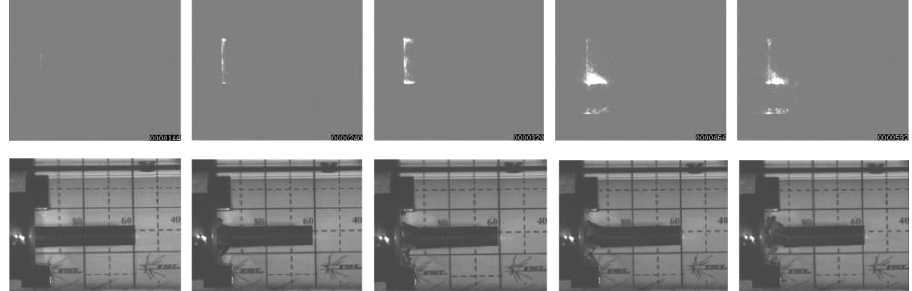
Fig. 1. Taylor tests: impact velocity of 97.5 m/s. Details of IIER (top) and fragmentation (bottom). No reaction was recorded at impact velocities below the threshold, indicating a link between fragmentation and impact-induced energy release. The results of the experiments are summarised in Table 1. The decrease in the residual mass of the recovered samples is tied with the increase in the number of fragments. Furthermore, these preliminary results seem to indicate that the dimensions of the fragments decrease with increasing velocities, as indicated by the fragmented mass recovered. Interestingly, it was also observed that the total sum of the mass recovered was less than the initial mass when energy release occurred.